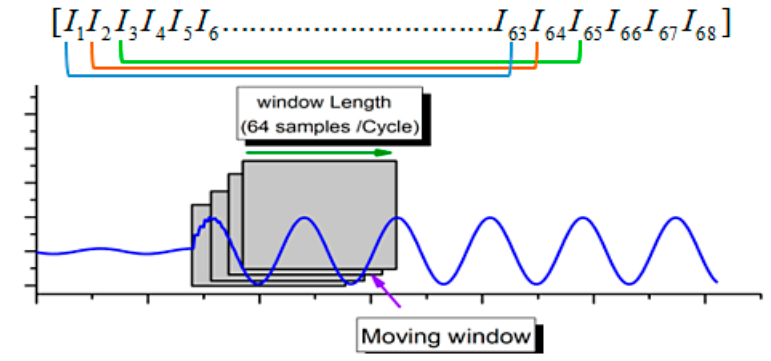
Figure 4. A sliding window to continuously monitor the CT saturation states at each instant. It discards the old samples from the window and inserts new samples towards the right.